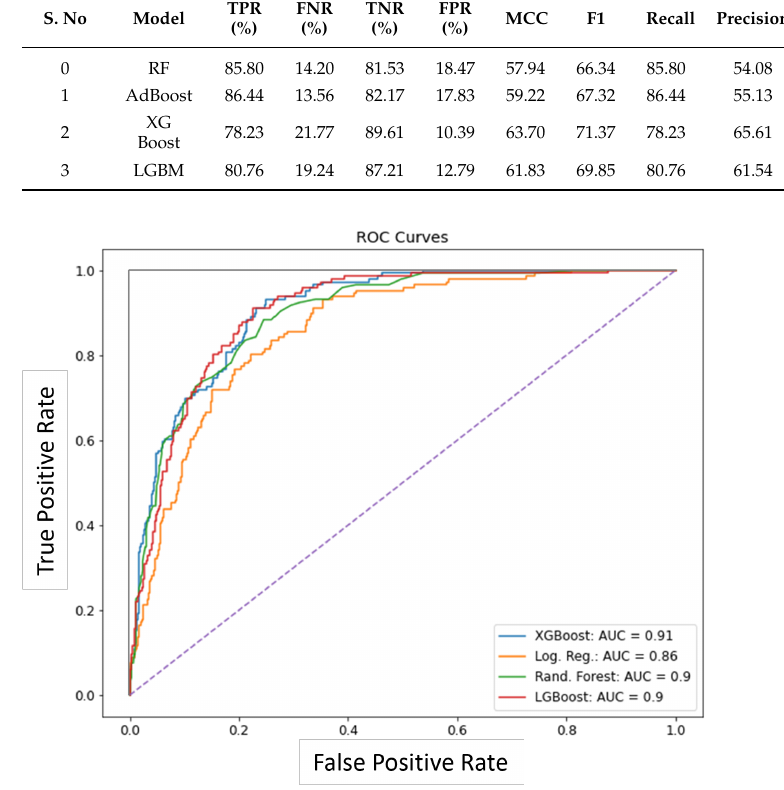
Figure 15. AUROC of pipeline suitability model.